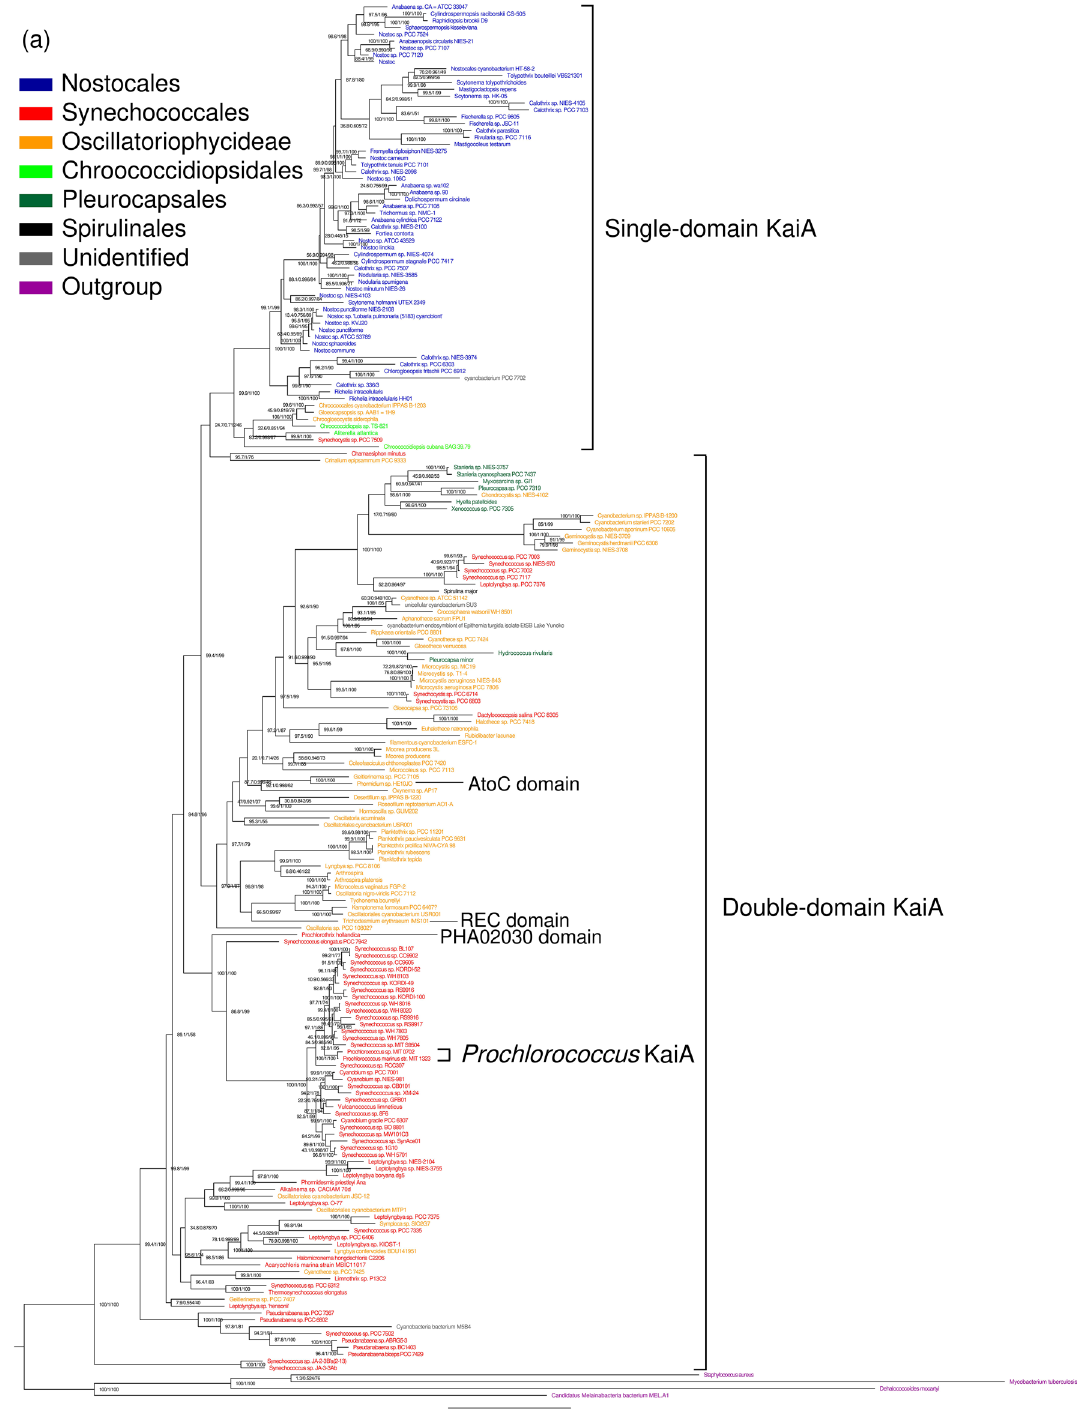
Figure 3. The maximum-likelihood phylogenetic trees of: ( a ) the 16S and 23S rRNA genes (species tree) and ( b ) KaiA homologs (gene tree). The node support values are ultrafast bootstrap/SH-aLRT branch test/ approximate Bayes